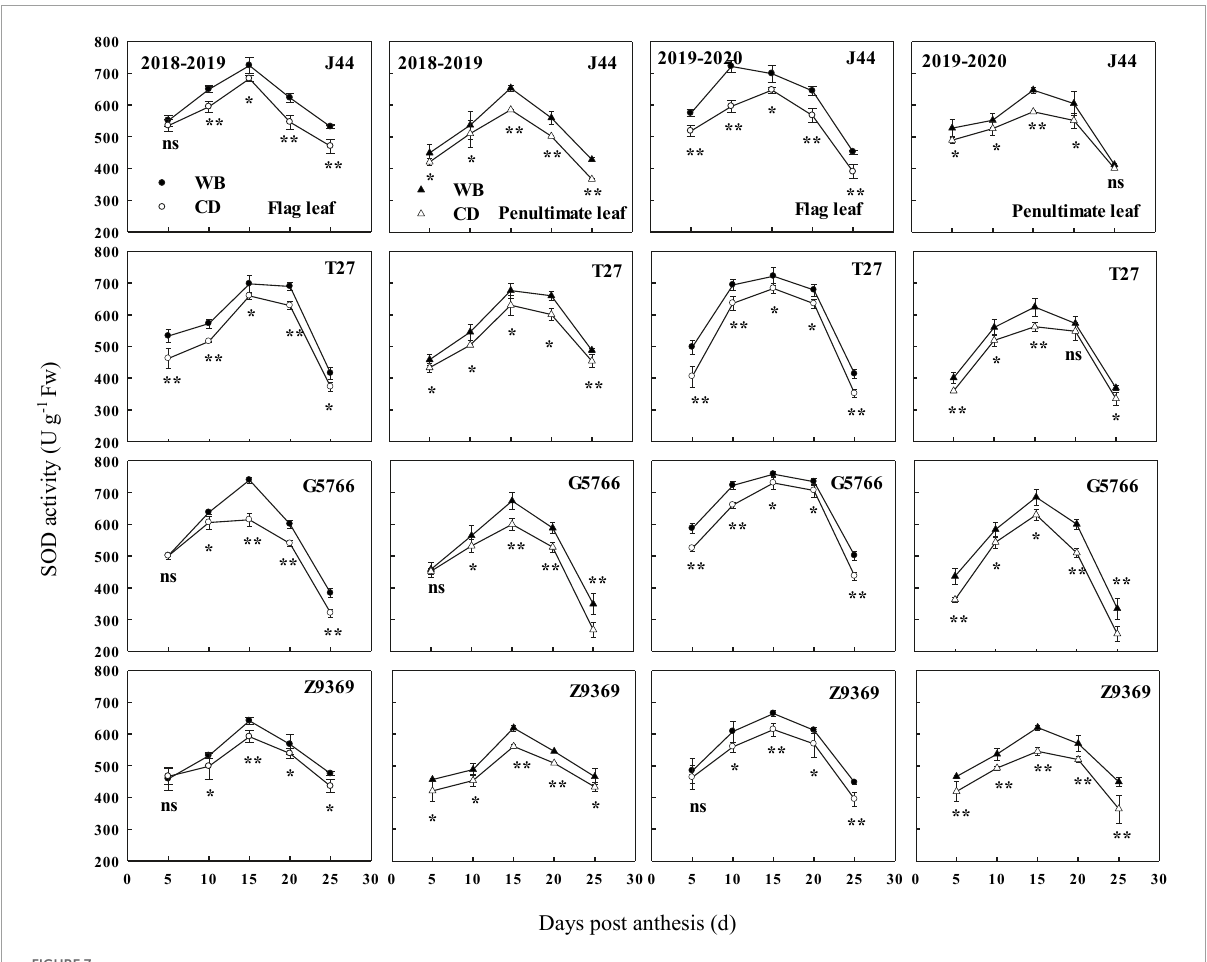
FIGURE7 Effects of sowing pattern on superoxide dismutase (SOD) activities of the flag leaf and penultimate leaf of bread wheat. Values are means of three replicates per treatment. Vertical bars indicate standard error. ns, *, and **Indicate significant differences at P ≥ 0.05, P < 0.05, and P < 0.01 between the two sowing patterns at each measurement time. CD and WB denote the conventional drilling and wide belt sowing pattern, respectively.